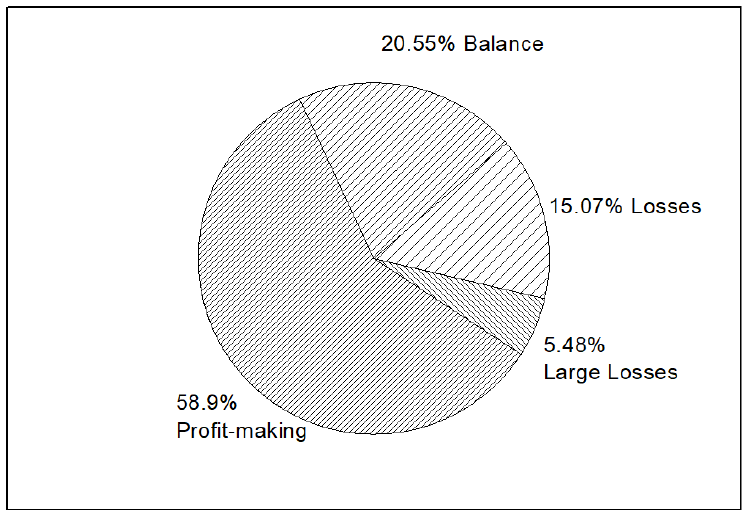
Figure 10. State of operation for the researched